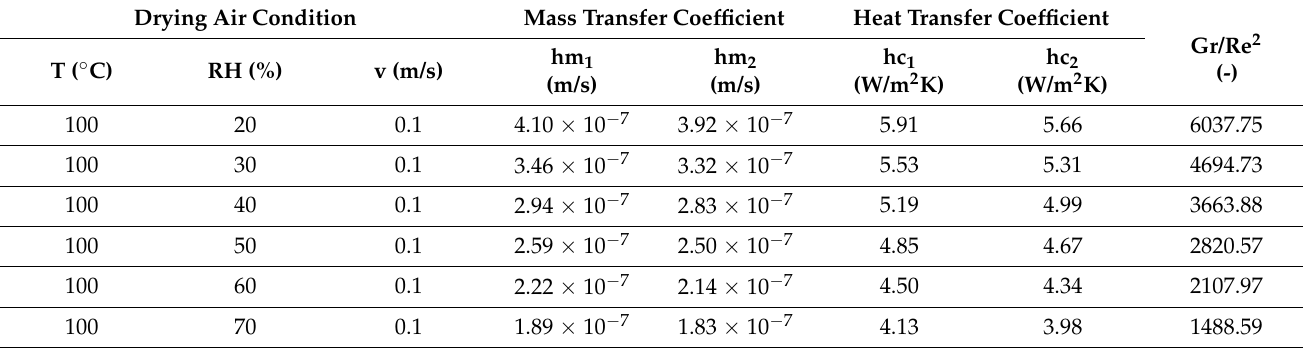
Table 7. Heat transfer coefficients and convective mass for different relative humidity of the drying air. Drying Air Condition